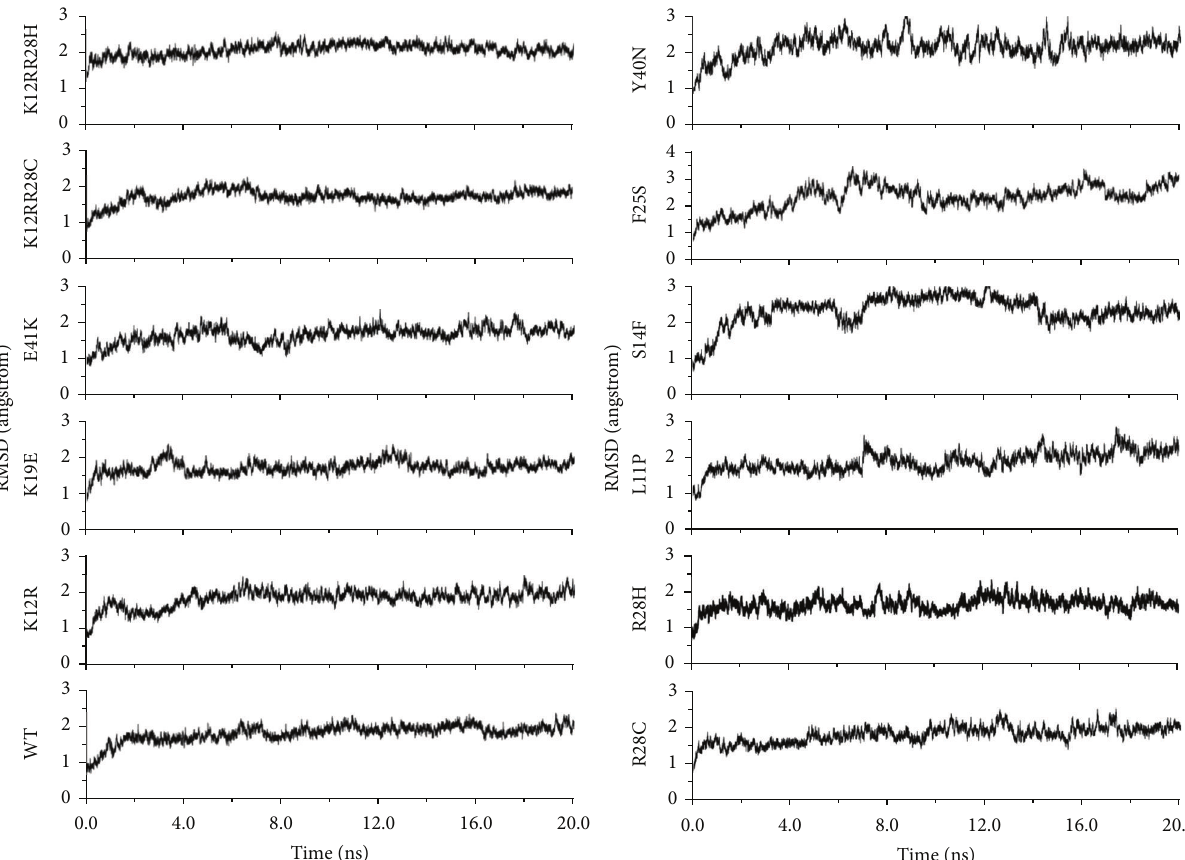
Figure1:Timedependenceoftheroot-mean-squaredeviations(RMSDs)fortheC 𝛼 atomsfromtheirinitialstructureof20 nsMDsimulations of all complex